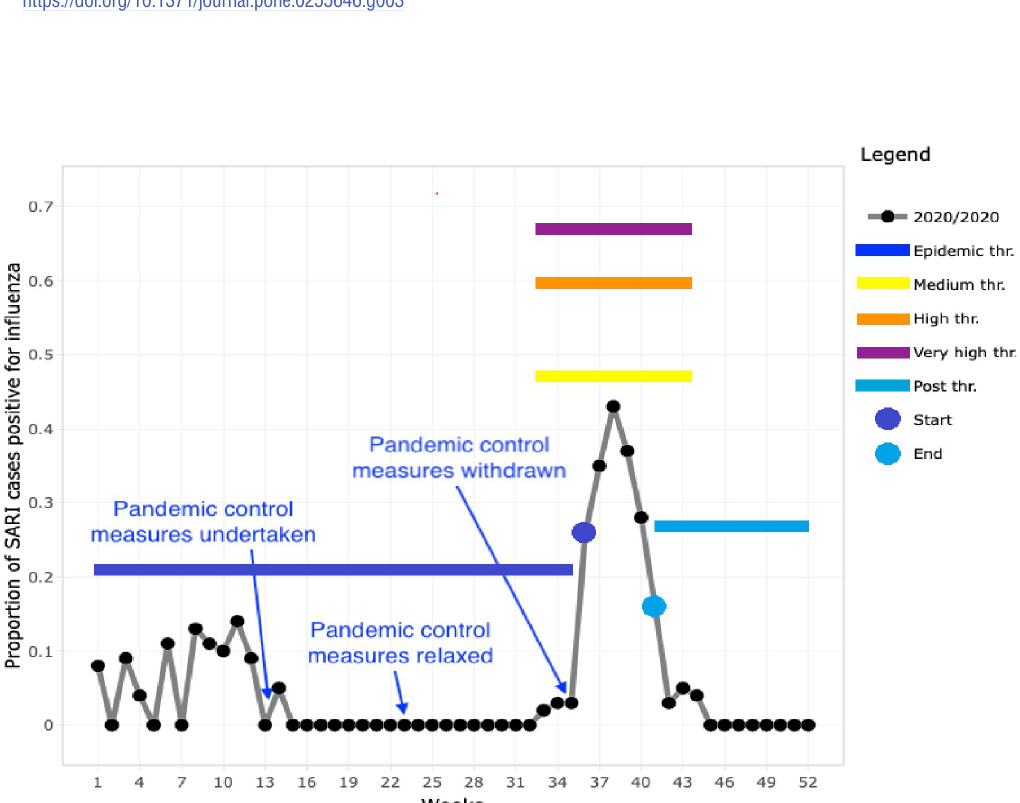
Fig 4. Epidemic threshold, levels of intensity and modelled influenza season 2020 in